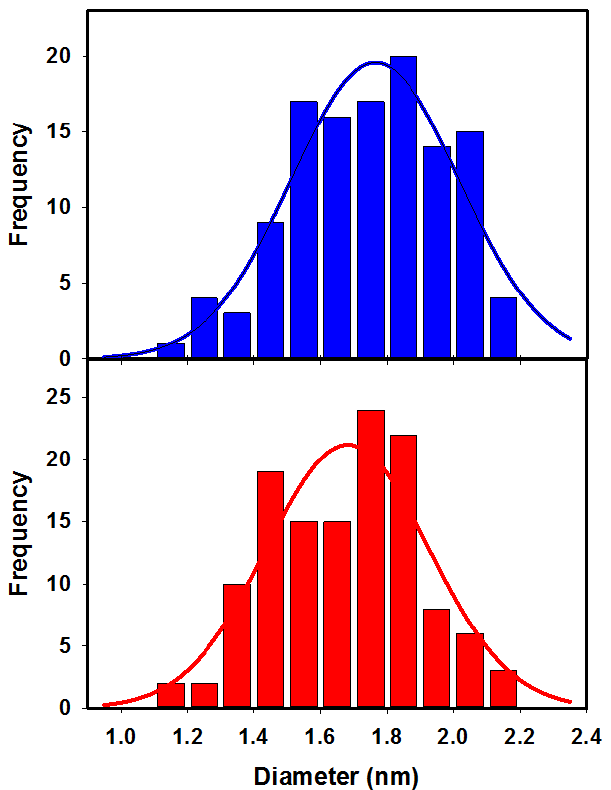
Figure 4. Histograms of the distribution of diameters measured on PFDD/SWCNTs using peak- force (Bruker) AFM ( blue ) on 120 nanotubes and intermittent contact-mode (JPK) AFM ( red ) on an additional 126 nanotubes. The red and blue solid lines represent Gaussian fits to the respective his- togram data.